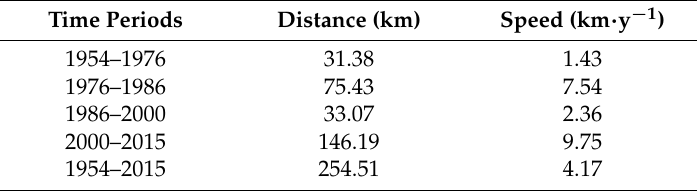
Table 3. The migration of the gravity center of paddy fields in different time periods.